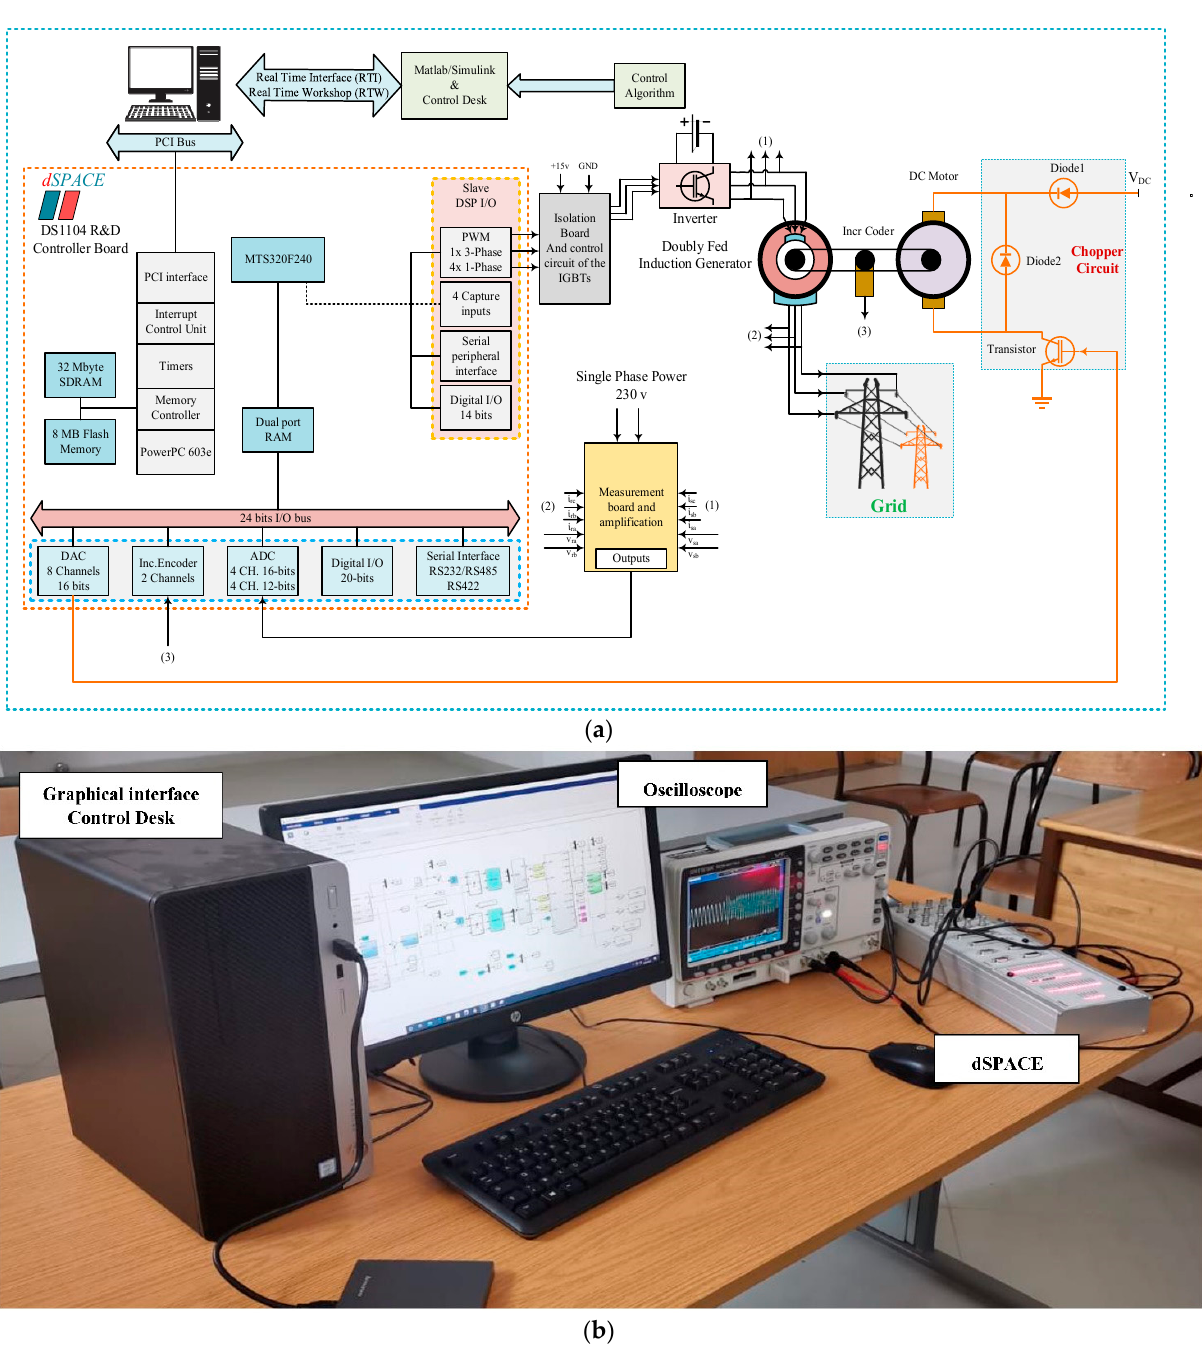
Figure 24. Structure of implementation of proposed strategy, ( a ) general methodology, ( b ) hardware setup.